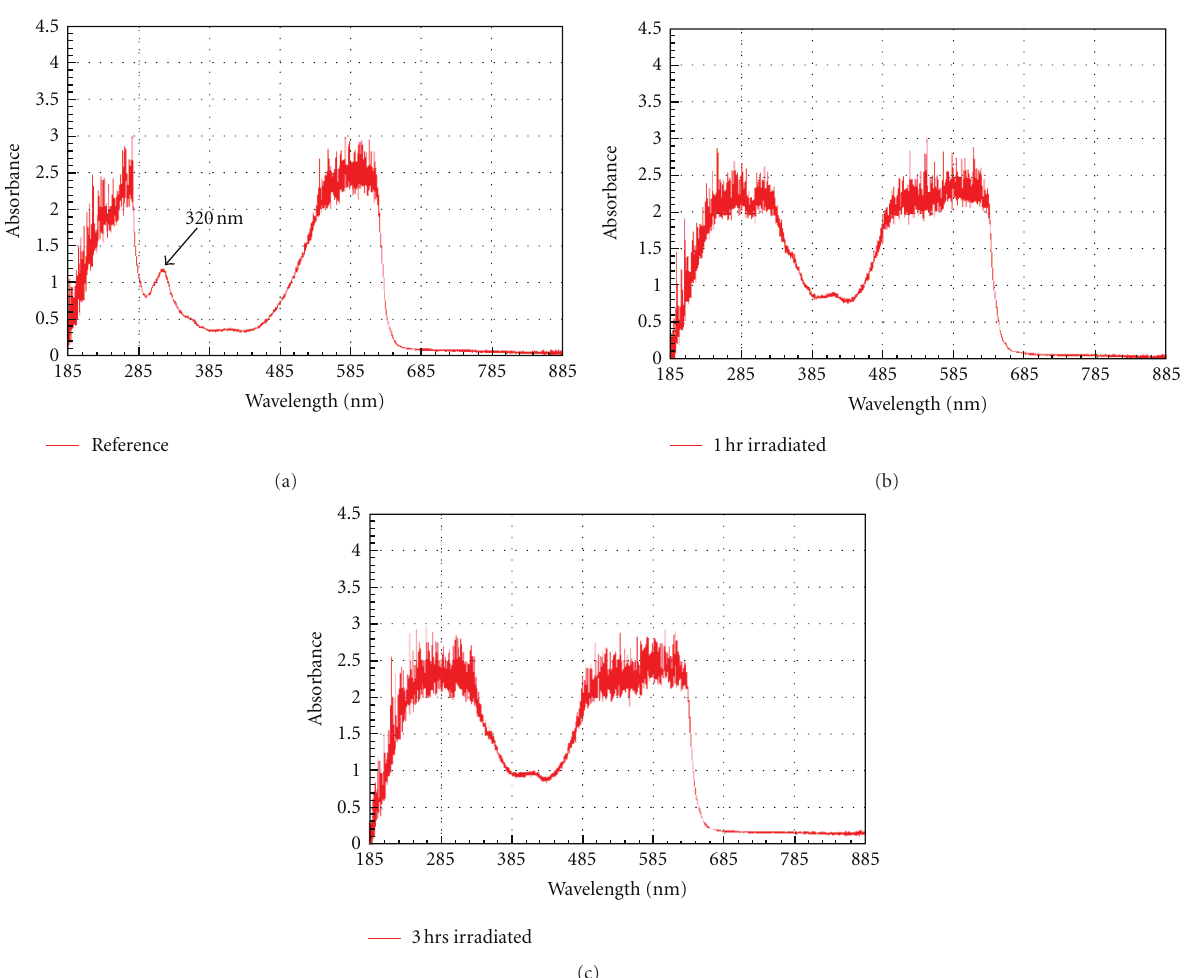
configuration of the irradiation experiment are illustrated in Figure